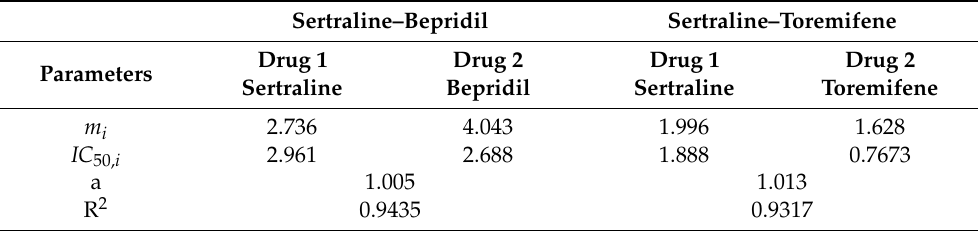
Table 4. In vitro PD parameters for drug